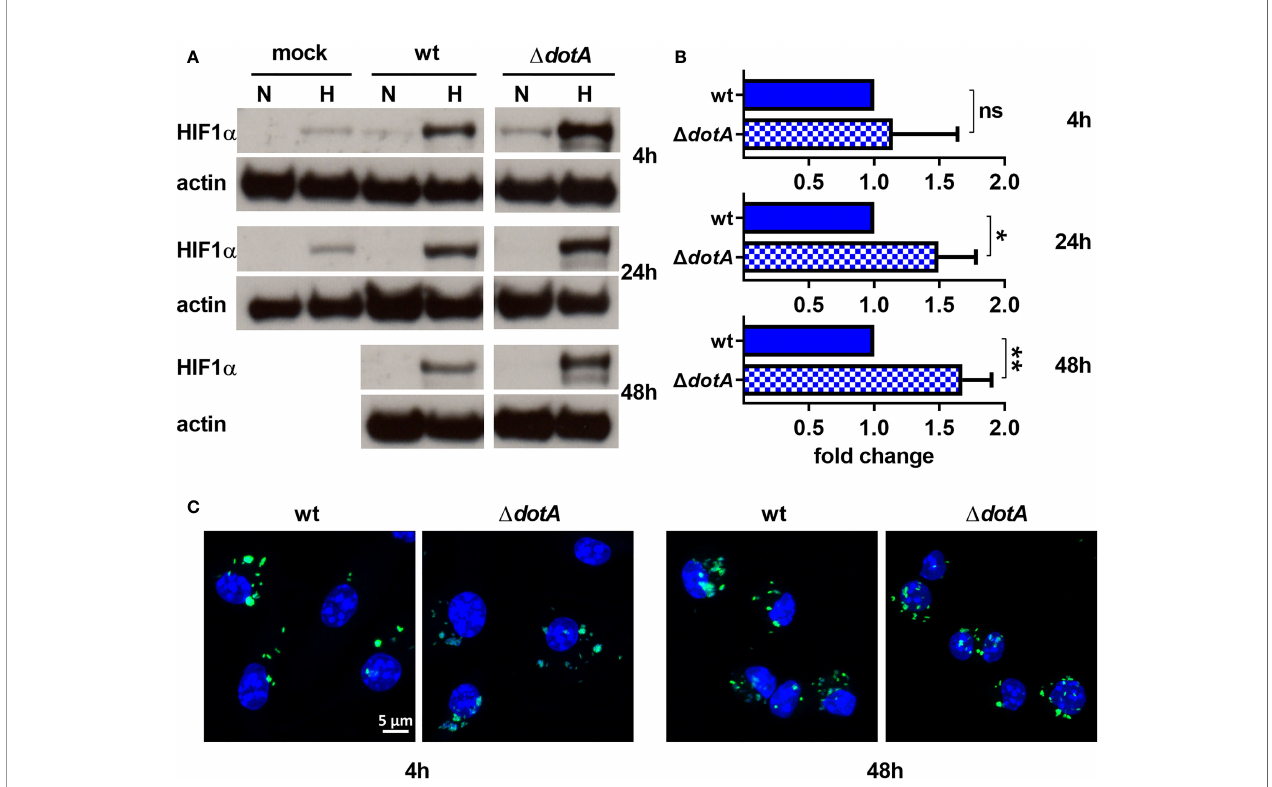
FIGURE 4 | C. burnetii reduces HIF1 a levels in a T4SS-dependent manner. (A, B) Murine BMDM either uninfected (mock) or infected with C. burnetii (wt) or C. burnetii lacking a functional T4SS ( D dotA ) for 4, 24 and 48 h under normoxia (N) or hypoxia (H) were analyzed by immunoblot using antibodies against HIF1 a and actin as loading control. Importantly, uninfected BMDMs were only cultivated for 24 h under hypoxia, as cell viability was signi fi cantly reduced at later time points. (A) One representative Western blot from 4 independent experiments is shown. (B) Densitometric analysis of the HIF1 a /actin ratio was performed using ImageJ. Fold changes under hypoxia (H) are shown relative to cells infected with wt. Mean ± SD, n=4, one-sample t-test. **p < 0.01, *p < 0.05, ns=p > 0.05. (C) Representative immuno fl uorescence micrographs of murine BMDM infected with C. burnetii (wt) (green) or the T4SS transposon mutant ( D dotA ) (green) for 4 and 48 h under hypoxia are shown. The cells were fi xed, permeabilized and stained with DAPI